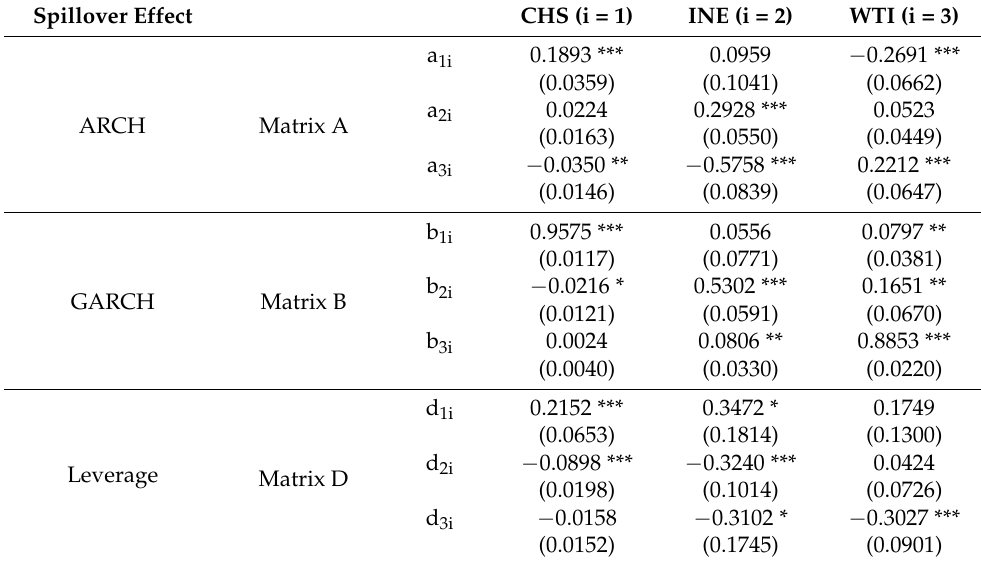
Table 9. Preliminary estimation results of the VAR (1)-BEKK-GARCH (1,1) model for the total